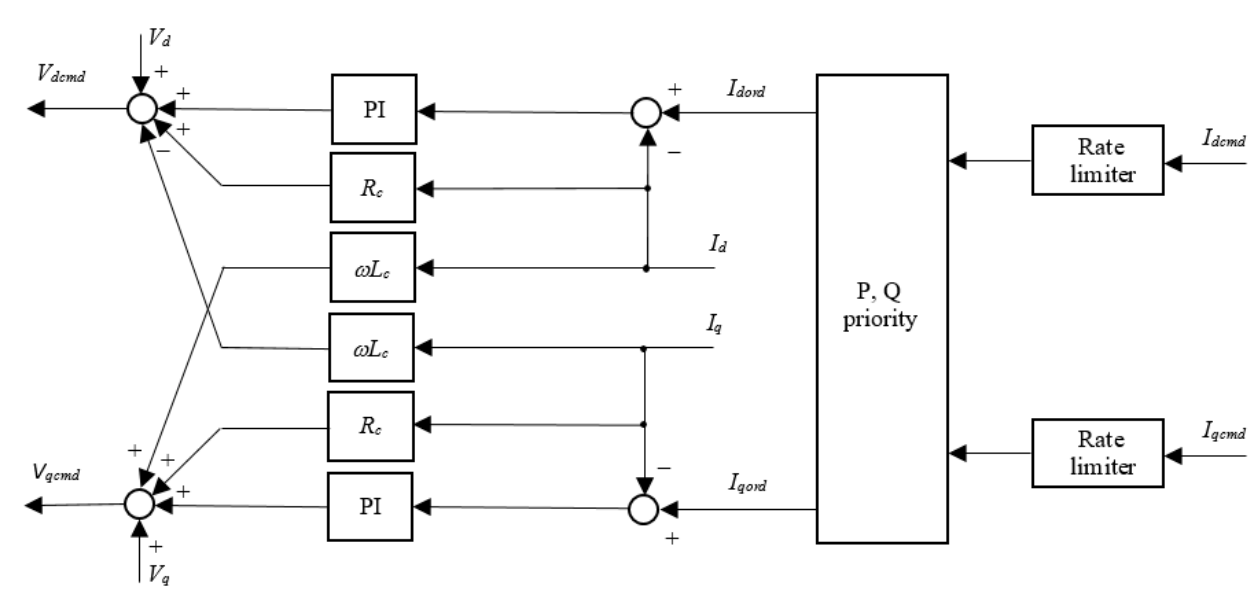
Figure 4. Decoupled Current controller of B2B converter.